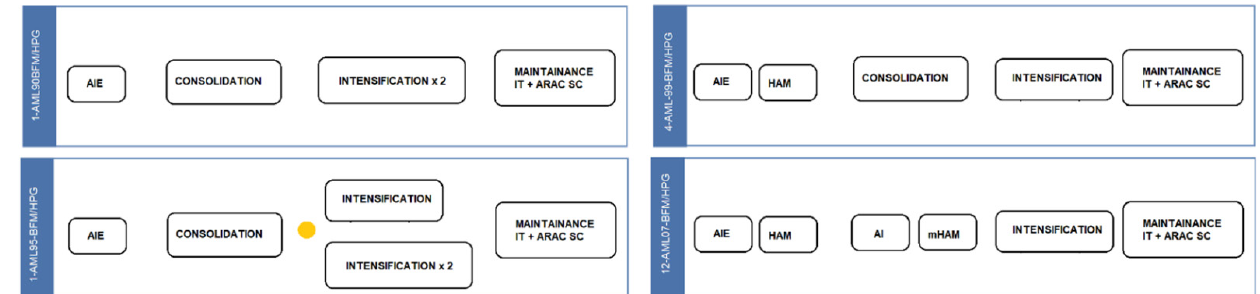
Figure 1. Overview of treatment schedules. AIE block: Cytarabine: 100 mg/m 2 , 24 h-IV infusion, days 1 and 2 Cytarabine: 100 mg/m 2 , 30 min-IV infusion, two doses, days 3–8 Idarubicin: 30 mg/m 2 , 4 h-IV infusion, days 3, 5, and 7 Etoposide: 150 mg/m 2 , 1 h-IV infusion, days 6, 7, and 8 DIT: doses according to patient’s age. Consolidation phase: Vincristine: 1.5 mg/m 2 , four doses, IV, weekly, weeks 1–4 Doxorubicin: 30 mg/m 2 , four doses, 6 h-IV infusion, weekly, weeks 1–4 Thioguanine: 60 mg/m 2 , seven doses per week, PO, daily, weeks 1–6 Cytarabine: 75 mg/m 2 , four doses per week, IV, weeks 1–6 Prednisone: 40 mg/m 2 , PO, daily, weeks 1–4 Cyclophosphamide: 500 mg/m 2 , two doses, IV, weekly, weeks 5 and 6 DIT: doses according to patient’s age, 4 doses, weeks 2, 4, 5 and 6. Intensification phase: HD Cytarabine: 3000 mg/m 2 , 3 h-IV infusion, two doses, days 1–3 Etoposide: 125 mg/m 2 , 1 h-IV infusion, days 2–5 DIT: doses according to patient’s age, day 1. Maintenance phase: Thioguanine: 40 mg/m 2 , daily, PO Cytarabine: 40 mg/m 2 , four doses per week, IV, monthly DIT: doses according to pa- tient’s age, monthly during continuation phase. Second induction (HAM): HD Cytarabine: 3000 mg/m 2 , 3 h-IV infusion, two doses, days 1–3 Mitoxantrone: 10 mg/m 2 , 1 h-IV infusion, days 3 and 4 DIT: doses according to patient’s age, day 1. AI block (consolidation phase): Cytarabine: 500 mg/m 2 , 24 h-IV infusion, days 1–4 Idarubicin: 7 mg/m 2 , 1 h-IV infusion, days 3 and 5 DIT: doses according to patient’s age, days 0 and 6. hAM block (Consolidation phase): Cytarabine: 1000 mg/m 2 , 3 h-IV infusion, two doses, days 1–3 Mitoxantrone: 10 mg/m 2 , 1 h-IV infusion, days 3 and 4 DIT: doses according to patient’s age, days 6 and 15.